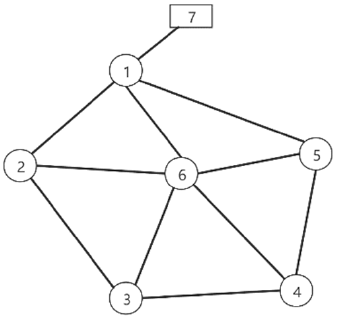
Figure 1. Schematic diagram of a typical looped water distribution network.